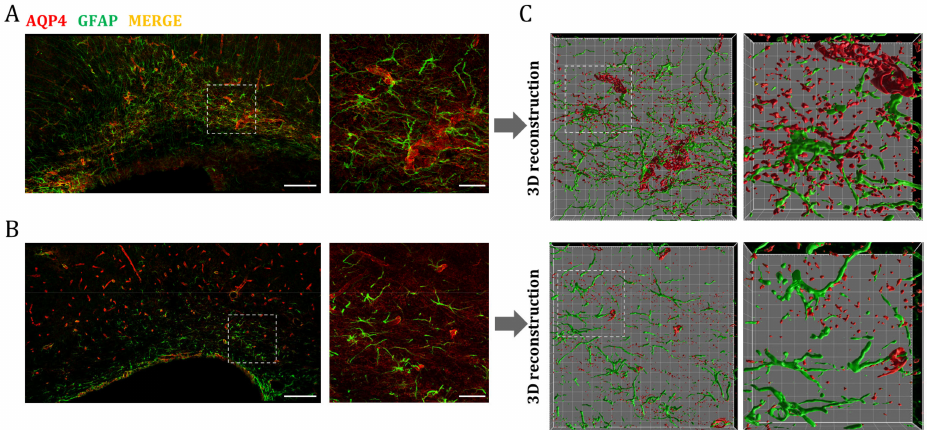
Figure 6. AQP4 overexpression in the postnatal corpus callosum coincides with the emergence of a maturing astrocyte population. Fluorescence immunhistochemistry of GFAP (green) and AQP4 (red) in corpus callosum at P7 ( A ) and P60 ( B ). Higher magnifications show an increased number of astrocytes (GFAP+/AQP4+ cells) at P7 that correlates with postnatal astrocytogenesis. Scale bar = 150 µ m; scale bar in the inset = 30 µ m. Volumes representing AQP4 and GFAP stained areas in higher magnification were generated by 3D rendering ( C ). Detailed cellular characterizations in each stage indicate differences in glial morphology and AQP4 distribution between premature (p7) and mature fibrous astrocytes (p60). Grid line increment = 5 µ